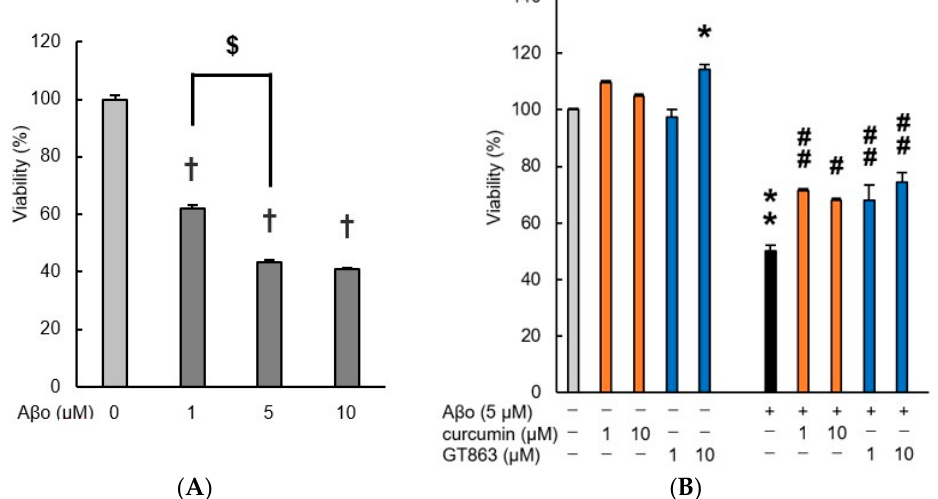
Figure 3. Cell viability of SH − SY5Y cells. Cell viability was evaluated by MTT assay. (A) Cell viability of SH − SY5Y cells exposed to A β o (1,5, 10 μ M) for 3 h. Each value is expressed relative to the viability of control (set to 100%). In the absence of A β o, the absorbance value of control for 3 h was 1.521 ± 0.0184 (mean + S.E.M). †, p < 0.0001 for control versus A β o − exposed cells ( n = 8, Tukey). $, p